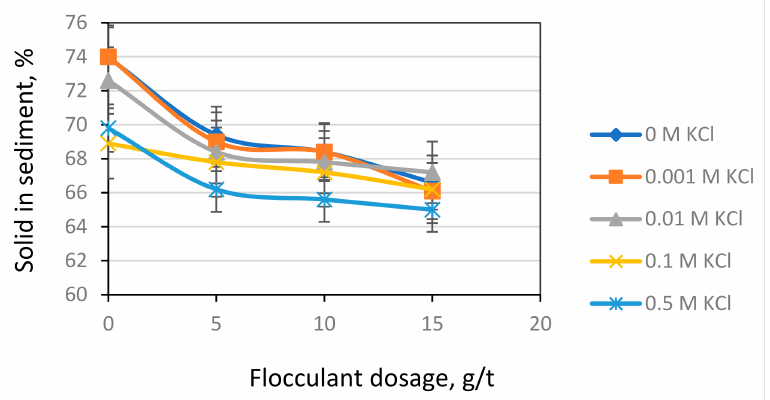
Figure 10. Percentage of solid in sediment with Magnafloc 338 flocculant, with deionized water.